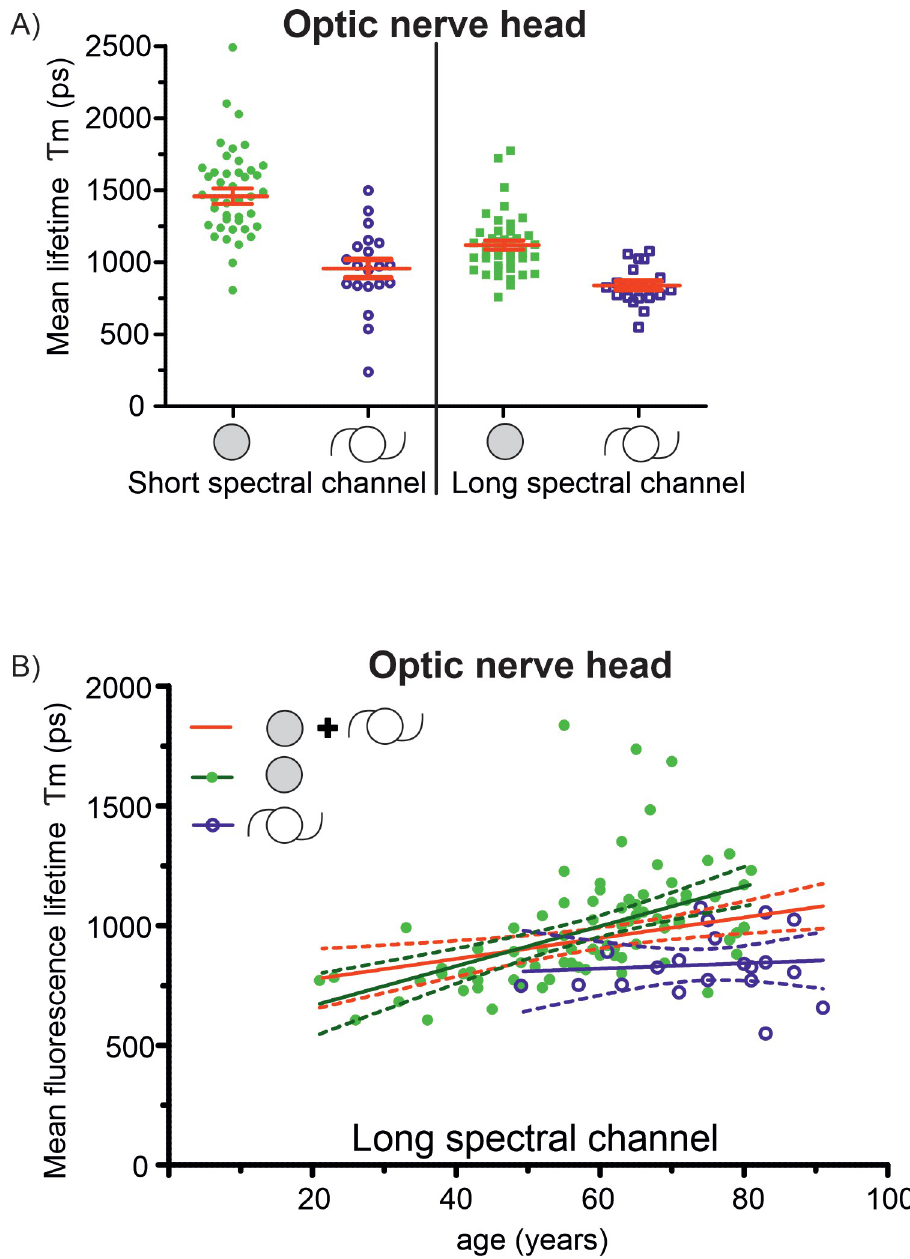
Fig 3. Fluorescence lifetime values of the optic nerve head. A) The mean fluorescence lifetime ( Tm ) in the optic nerve head was significantly shorter in pseudophakic compared to phakic eyes in both spectral channels (p = 0.0001 and 0.0081, resp). In the figure, only data from subjects � 50 years is shown. The measured FLT value of the optic nerve in pseudophakic subjects corresponded to the FLT values of the optic nerve in healthy younger subjects. B) There was a slight increase of fluorescence lifetimes of the optic nerve head with age in phakic subjects (r 2 = 0.26, p < 0.0001). However, in pseudophakic subjects no increase of fluorescence lifetime values in the area of the optic nerve was measured (r 2 = 0.0078, p =